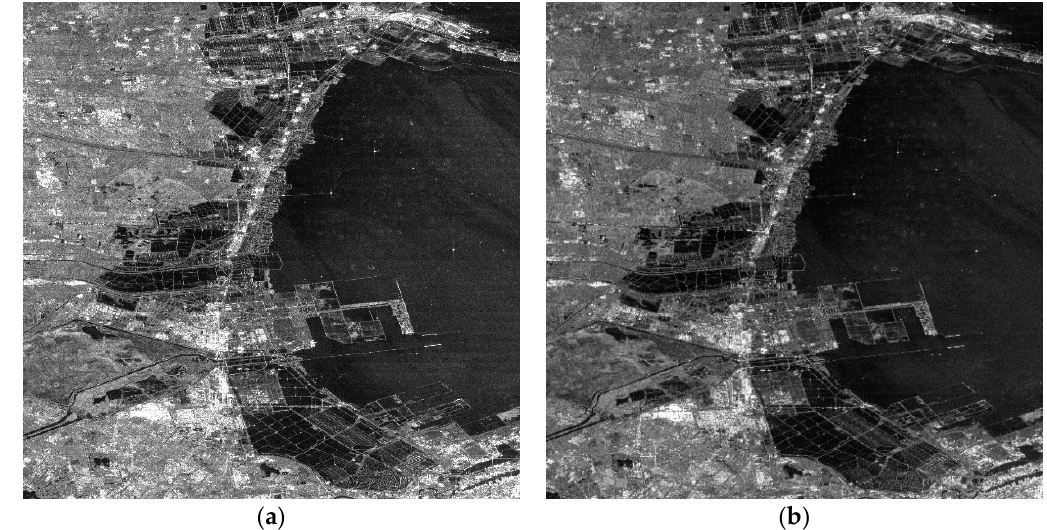
Figure 20. Descalloping effect of Bohai bay: ( a ) before descalloping; ( b ) after descalloping.